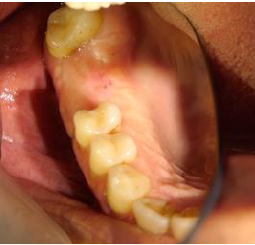
Figure 10. Appearance of the tissues after eight months of healing. A very well represented crest can be observed.